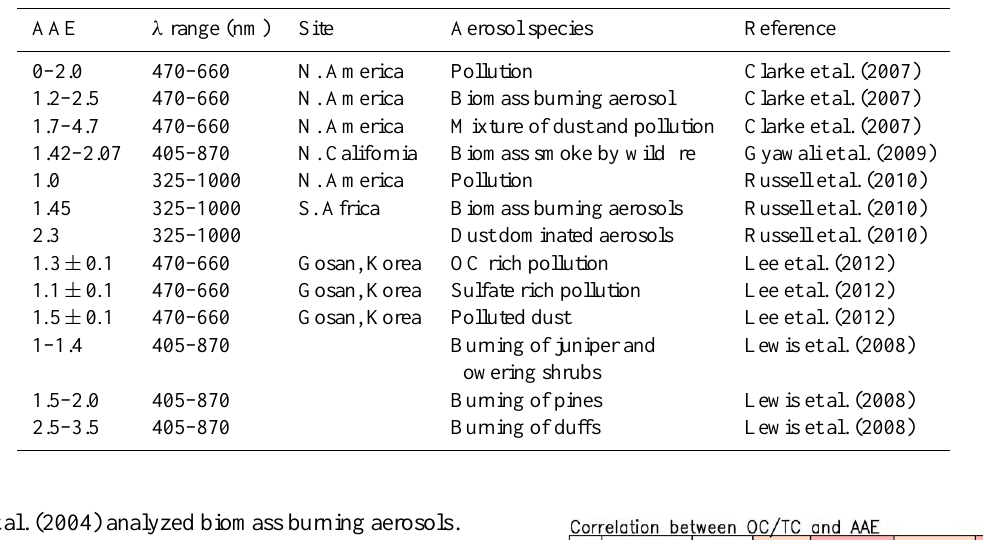
Table 2. Reported ambient aerosol AAE.